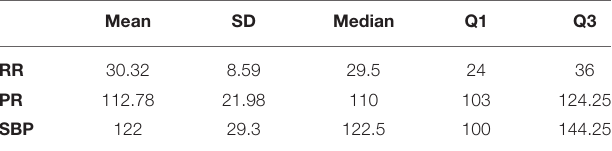
TABLE 2 | Hemodynamic status of patients.